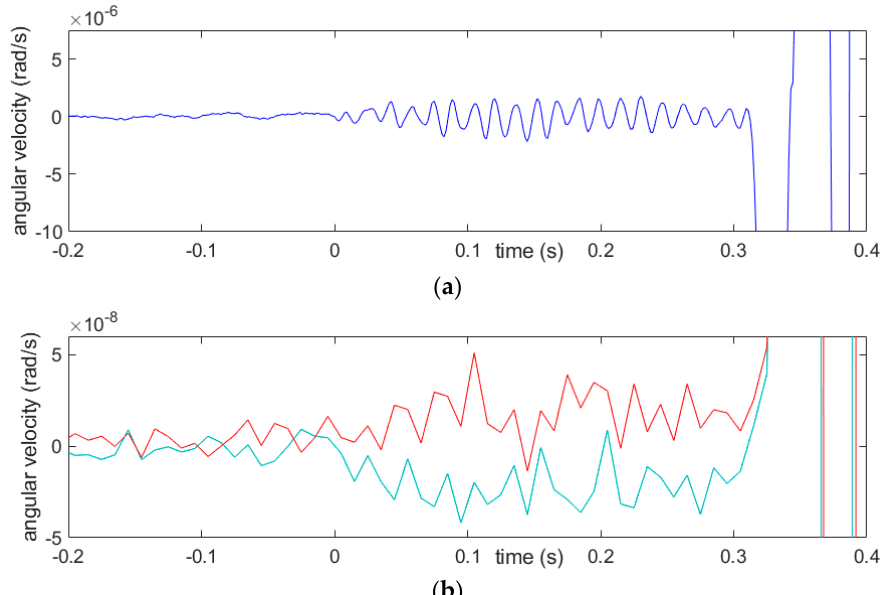
Figure 6. Low-amplitude initial part of the signal, as seen ( a ) in the recording from FOSREM and ( b ) in the symmetric strain rate (lower, turquoise line) and the rotation rate (upper, red line) calculated from the TAPSs. The solitary blast in corridor, No. 48, 26 April, was 73 g of the explosives. The timespan of the blast record in its first part did not exceed about 0.4 s–0.6 s, which was not much more than the greatest time delay of the elemental explosion (0.375